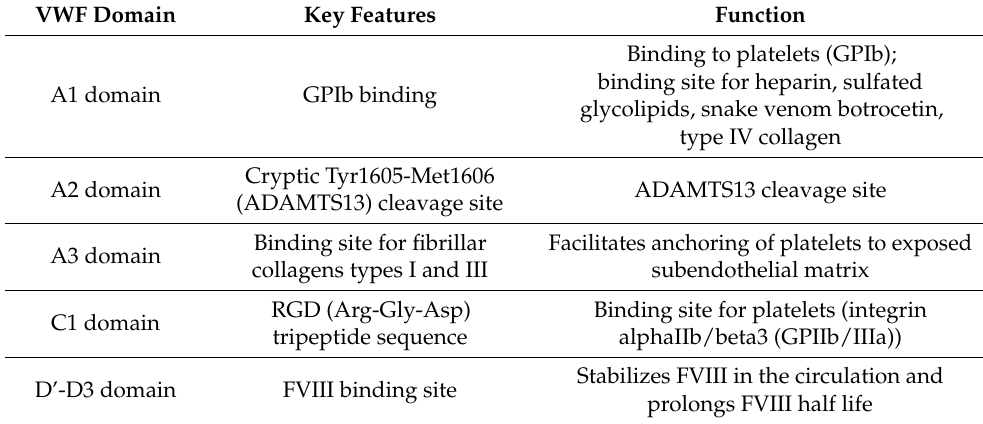
Table 1. VWF domains and